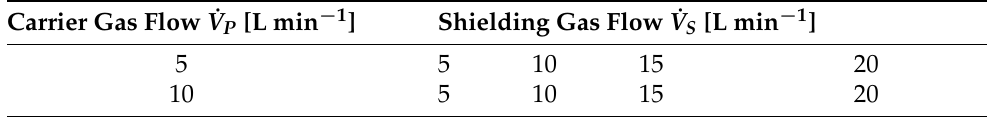
Table A3. Full-factorial design to study the interdependencies between linear energy input and mass